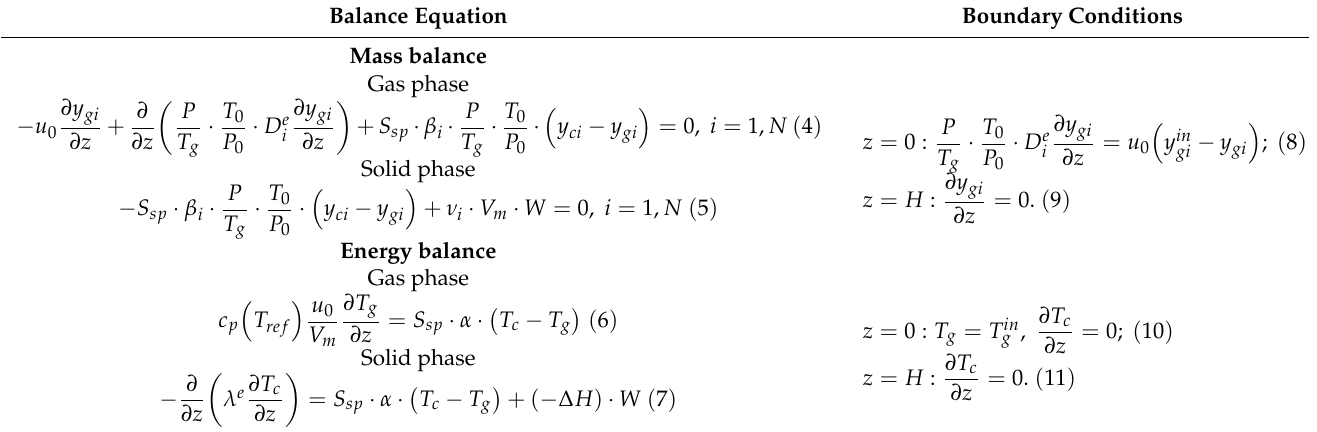
Table 4. The stationary non-isothermal mathematical model of the catalytic process in adiabatic